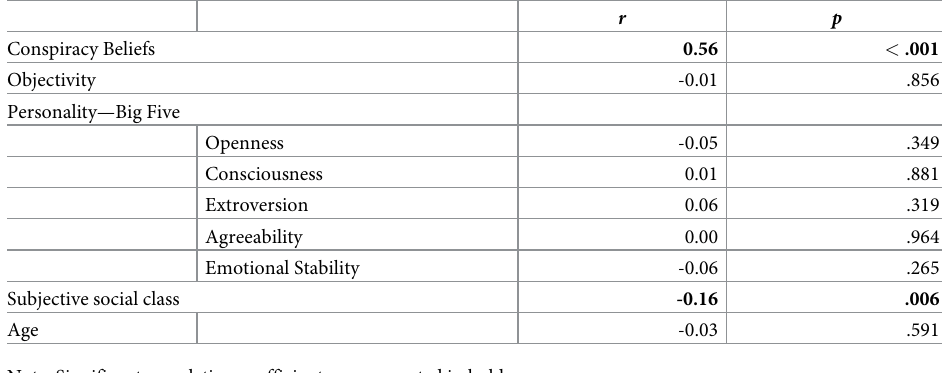
Note. Significant correlation coefficients are presented in bold.